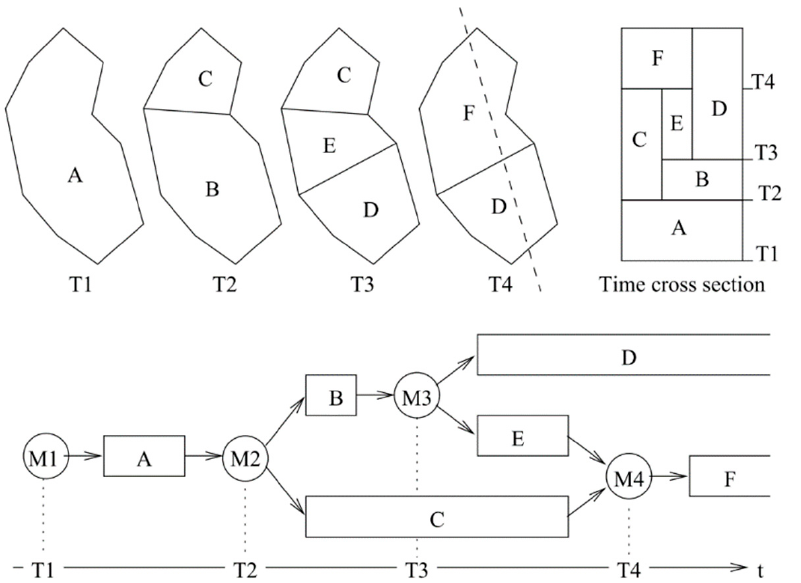
Figure 3. Example of the evolution of a land area represented by states and transitions (from [37] ).